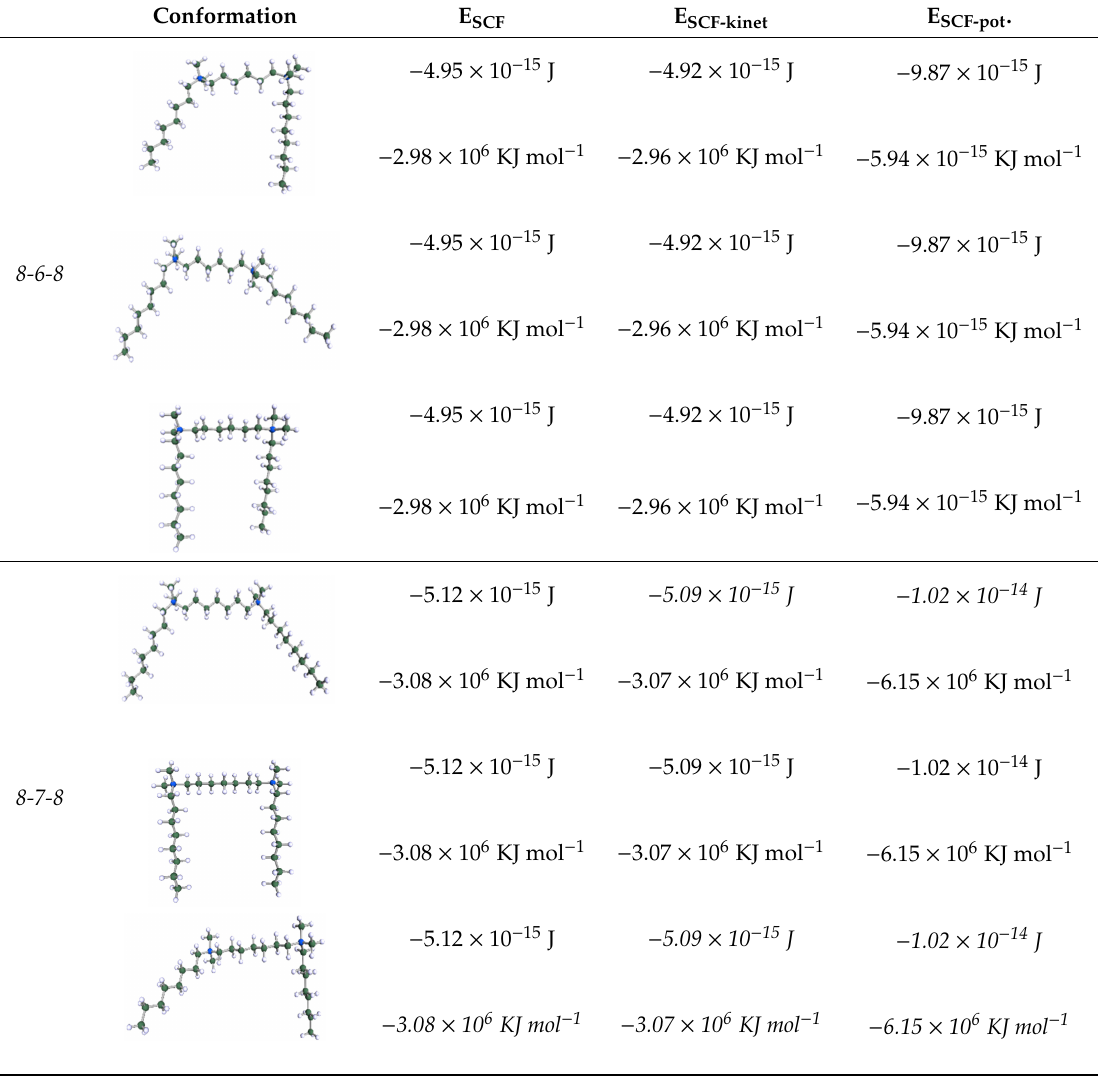
Table 3. SCF energies (E SCF ): kinetic E SCF-kin. and potential E SCF-pot. of surfactant conformers in aqueous solutions optimized at the B3LYP / def2–TZVP. Conformation